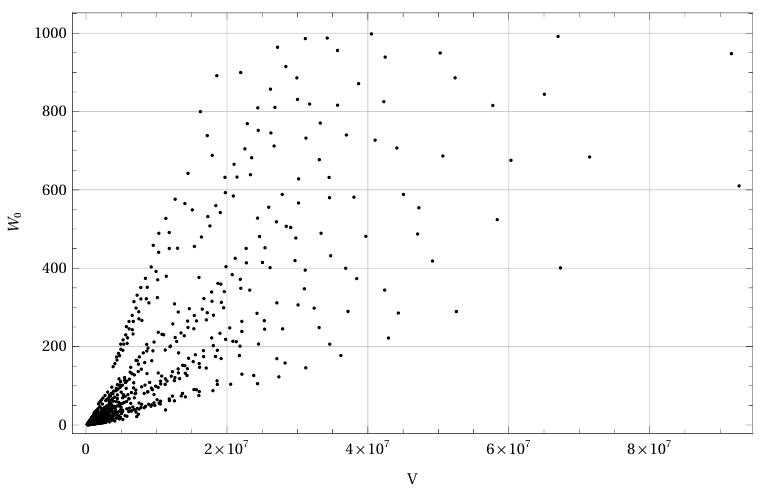
Figure 7 . Points in the ( W 0 , V ) plane which match the observed amplitude of the density pertur- bations and DM